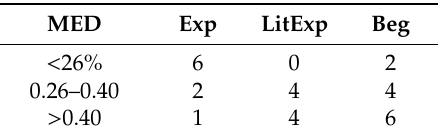
Table 5. Distribution of testers ( n ) according to the amount of MED sorted by groups experienced (Exp), little experienced (LitExp) and beginners (Beg).